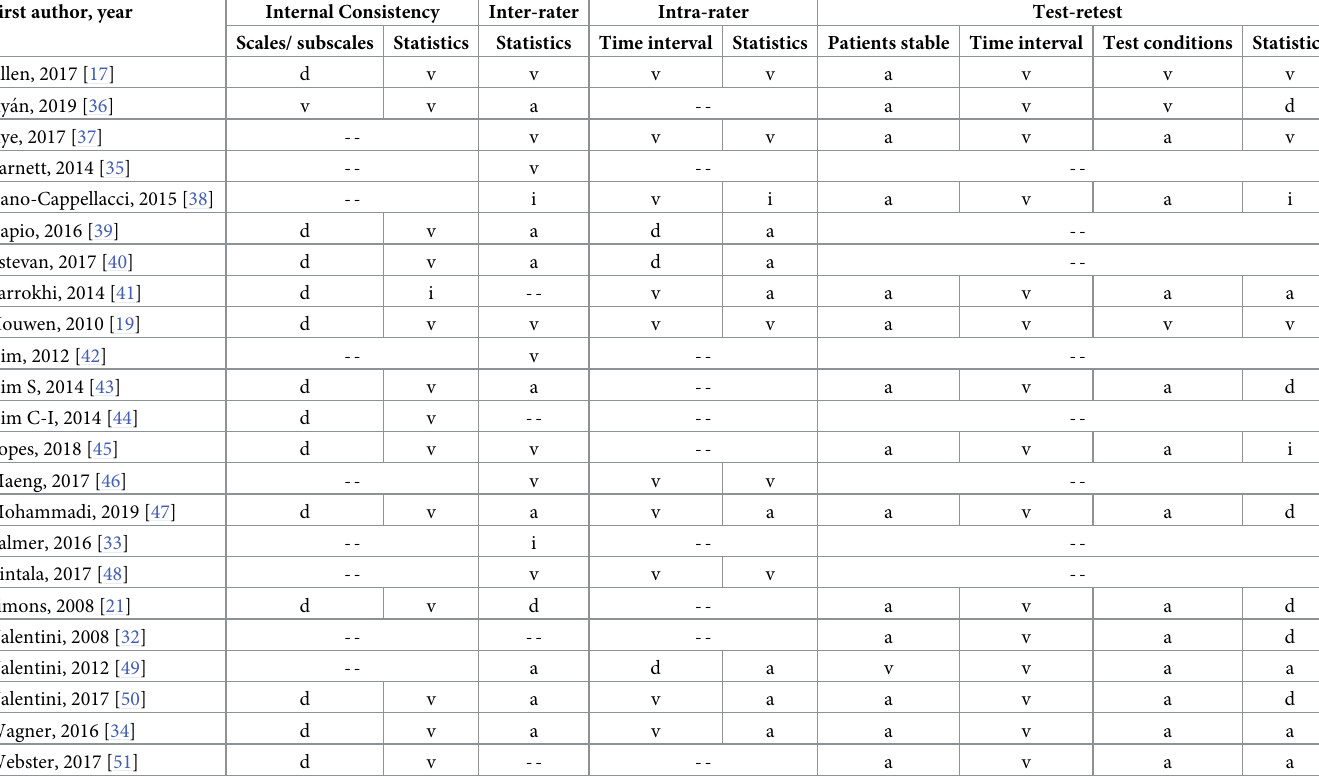
Table 4. Quality assessment of the studies using the COSMIN